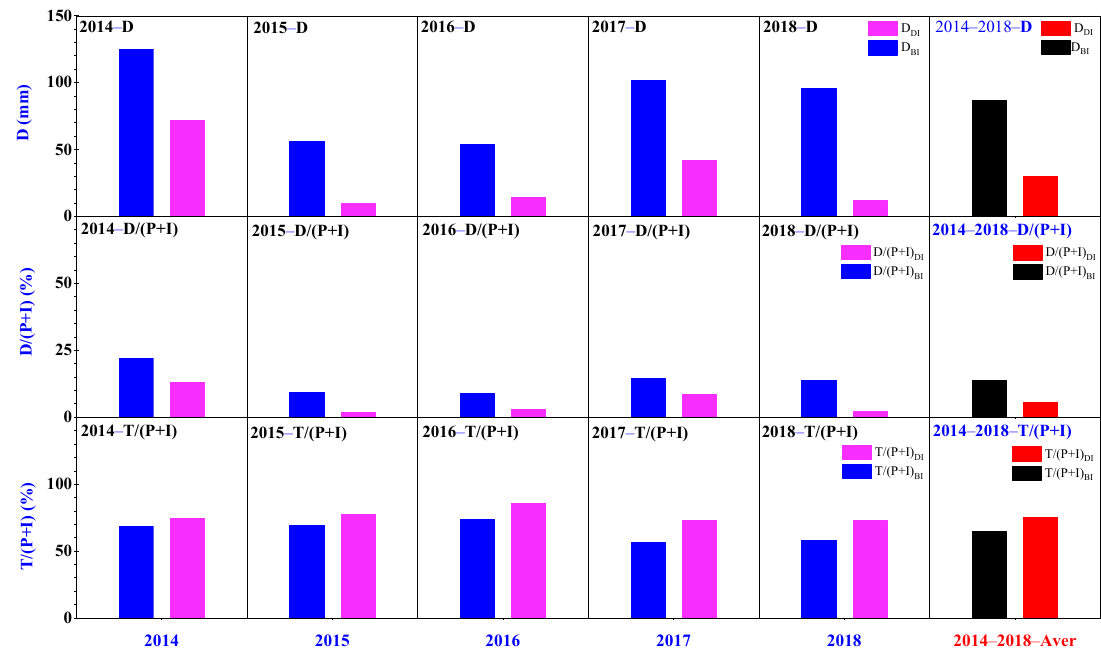
Figure 4. Comparison of drainage (D), D/(P+I) and effective water utilization (T/(P+I)) under BI treatment and DI treatment during 2014–2018.